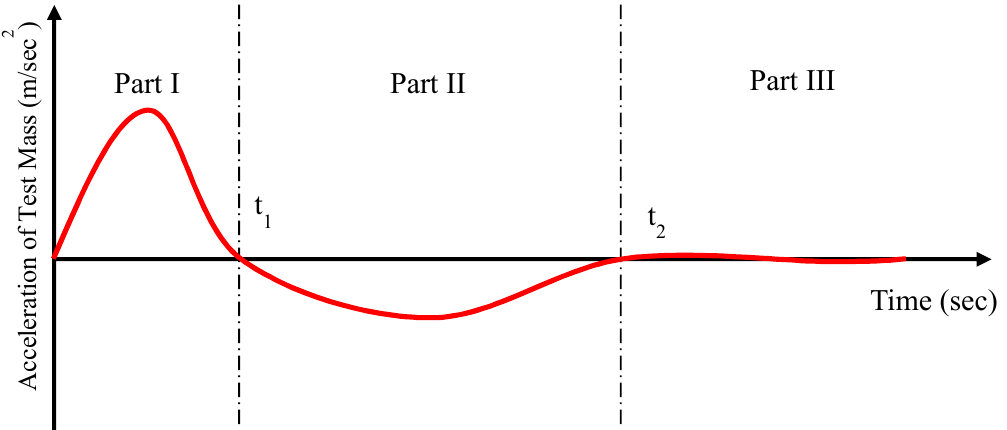
Figure 2. Shape of the double pulse waveform profile.